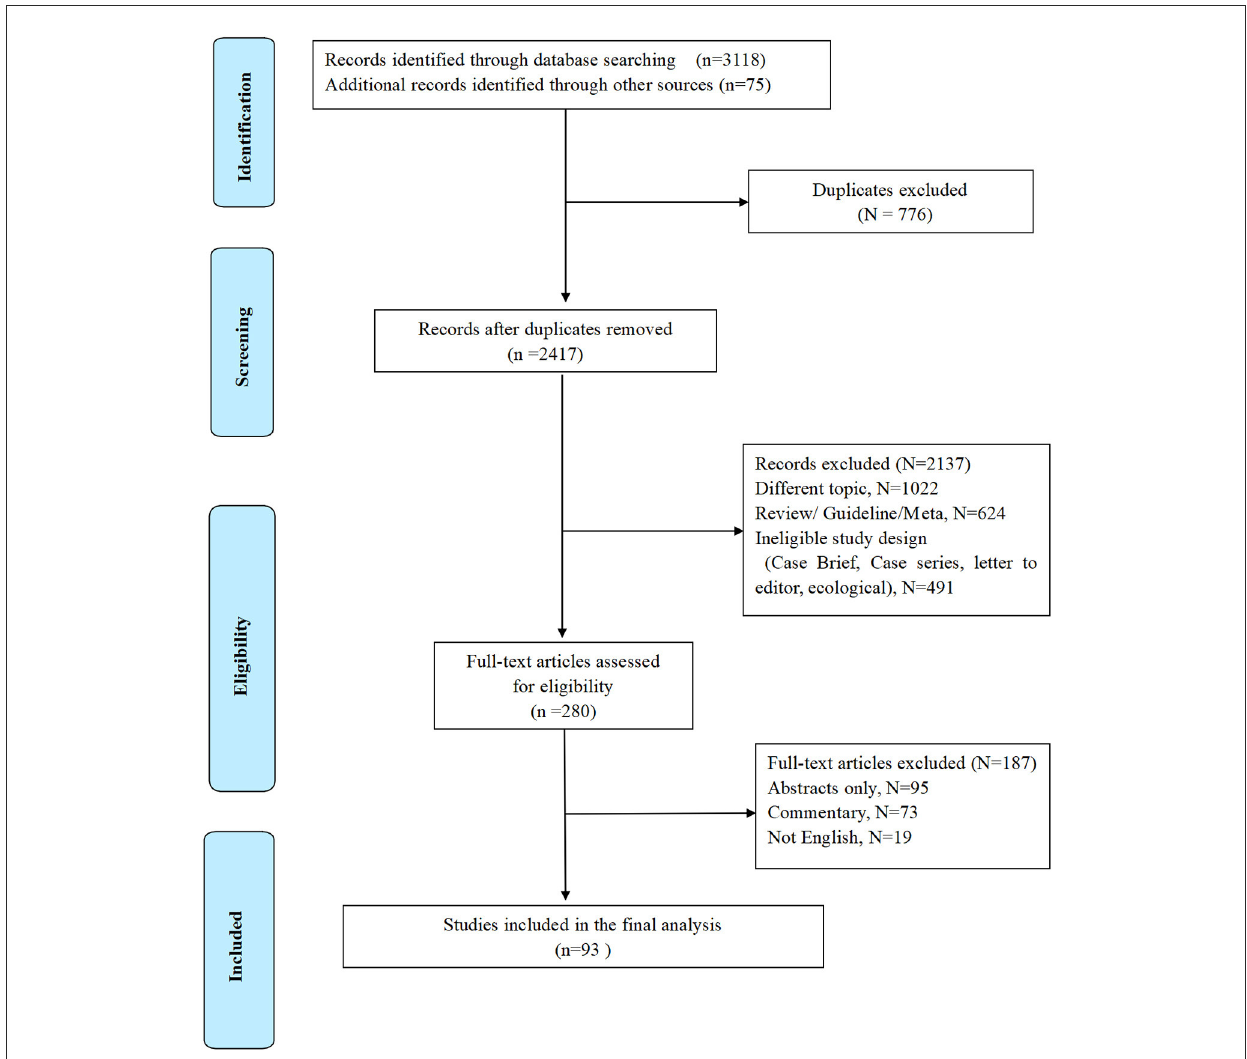
FIGURE1 Flow diagram of study selection.